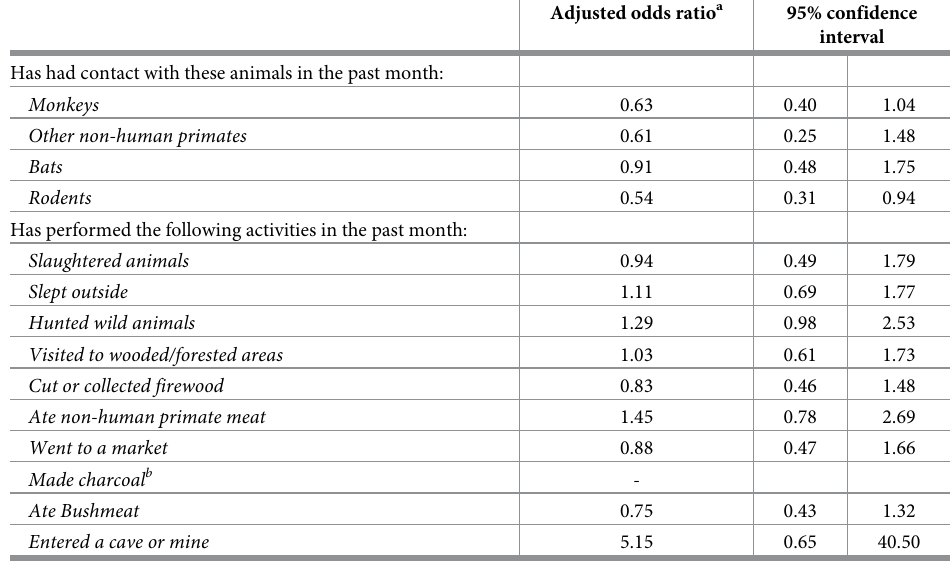
a. Adjusted for age, sex, healthcare worker status, known contact with an Ebola Virus Disease case, and study